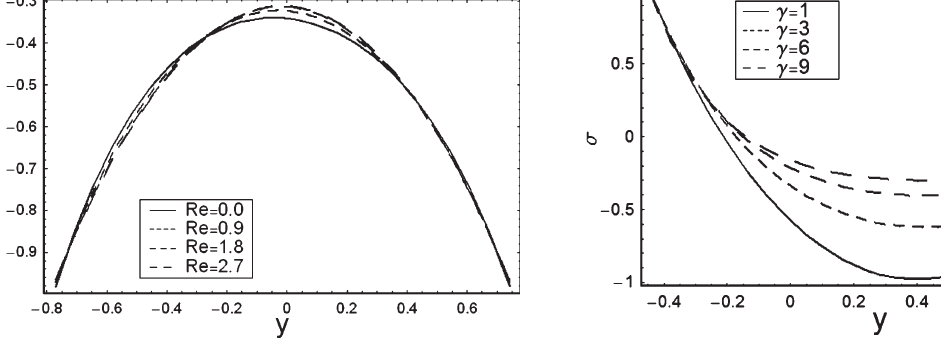
Fig. 18. Variation of γ on σ when a = 0 . 2, b = 0 . 8, d = 1, β